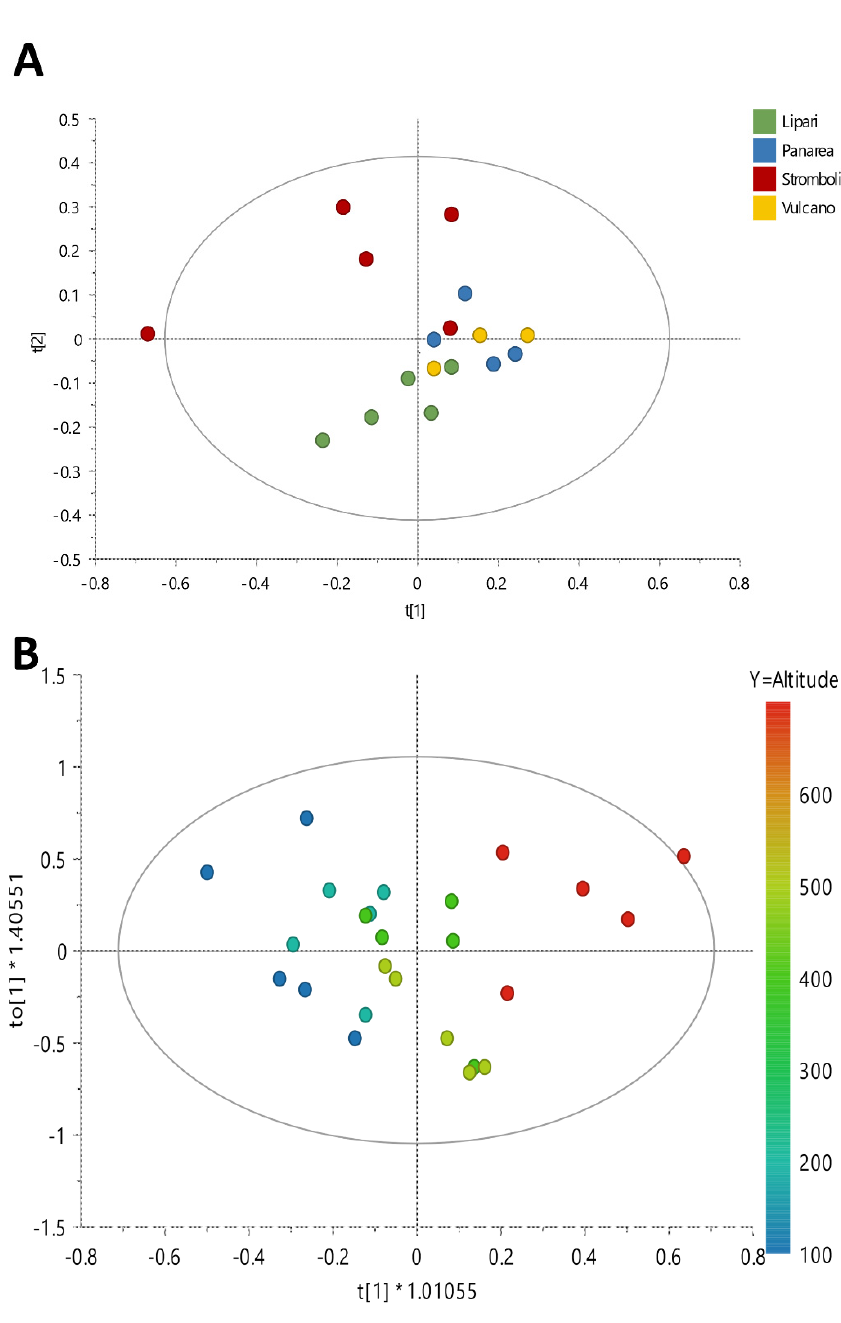
Figure 1. ( A ) PCA Score Scatter Plot and ( B ) OPLS Score Scatter Plot ( y = altitude). OPLS performed well, as indicated by the coefficients: R 2 (cum) = 89% and Q 2 (cum) = 0.712%, and it was further validated by the permutation test ( R 2 x (cum) = 77%; Q 2 (cum) = 65%) and ANOVA of the cross-validated residuals (CV-ANOVA) ( p = 2.21 × 10 − 4 , F = 9.19). This analysis confirmed that the metabolome of D. glomerata growing on Stromboli Island varied at different altitudes. A semi-quantitative analysis of the most varying metabolites